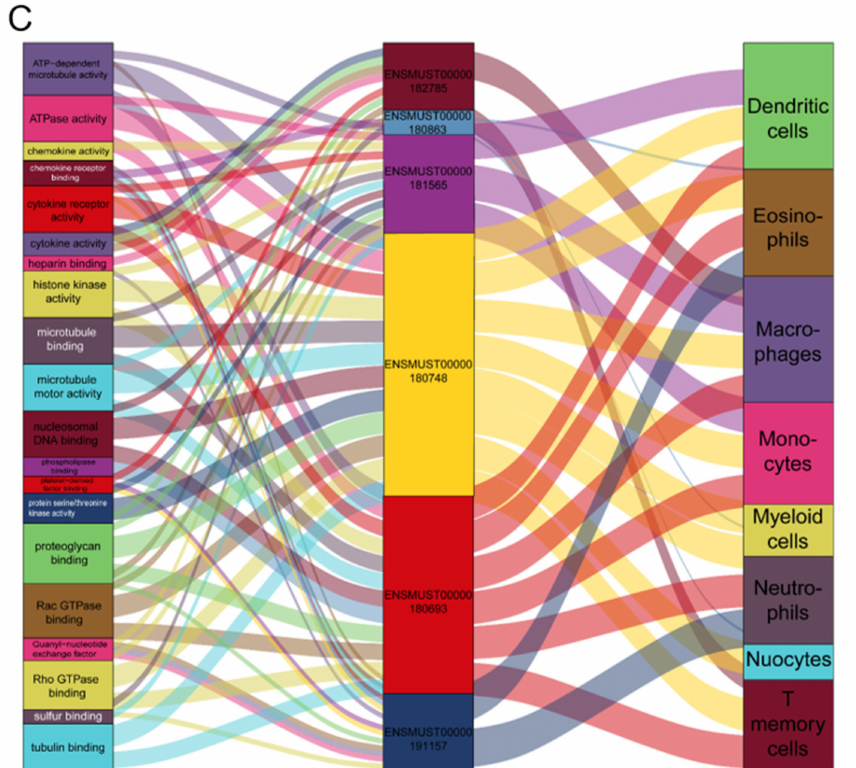
Figure 6. LncRNA–mRNA–immunocyte correlation network. ( A ) The co-expression network shows the correlation between immune-related lncRNAs and differentially expressed mRNAs, and the cutoff value was set with a threshold of correlation > 0.9 and p adjusted < 0.01. The yellow, orange, and red nodes represent lncRNAs by category according to the number of their connections with other genes, and blue nodes represent mRNAs. ( B ) The co-expression network of lncRNAs and infiltrated immunocytes. 35 key nodes are shown in the network. ( C ) The Sankey diagram summarized the relations between lncRNAs, the types of immunocytes, and the GO terms of correlated protein-coding mRNAs